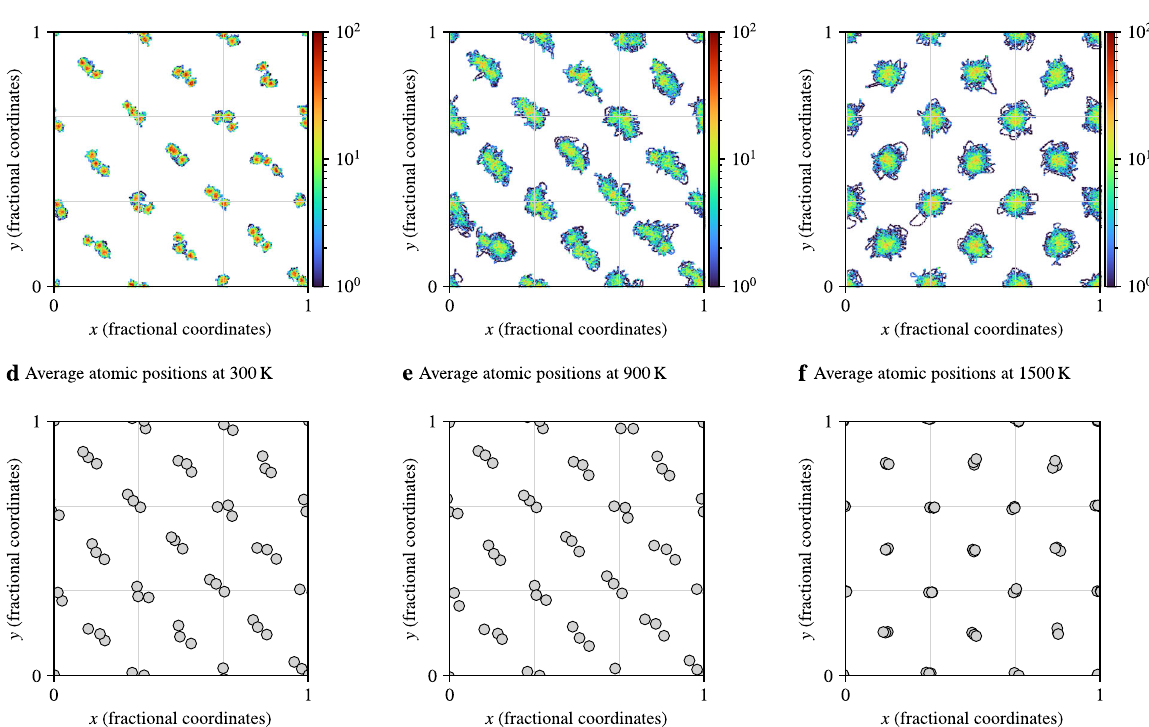
Fig. 4 Atomic positions for a 54-atom model of TiZrHf at the bcc lattice parameter of ≈ 3.469 Å from ab initio MD simulations. The thin gray grids correspond to the boundaries of the 2-atom conventional bcc unit cells. a – c Two-dimensional histograms of the atomic positions projected onto the {001} bcc plane at the corresponding temperature. The histograms are normalized into one and color-coded in a log scale. d – f Mean atomic positions at the corresponding